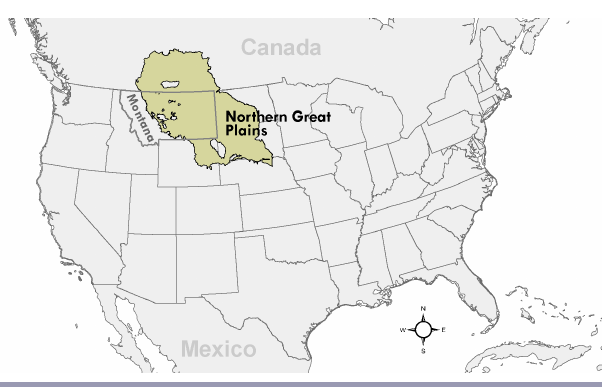
Fig. 1 . The northern Great Plains